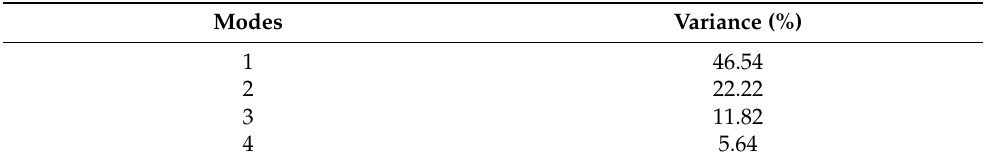
Table 2. Percentage of variance explained by the first four modes of variability of the surface pressure (SP) residuals.